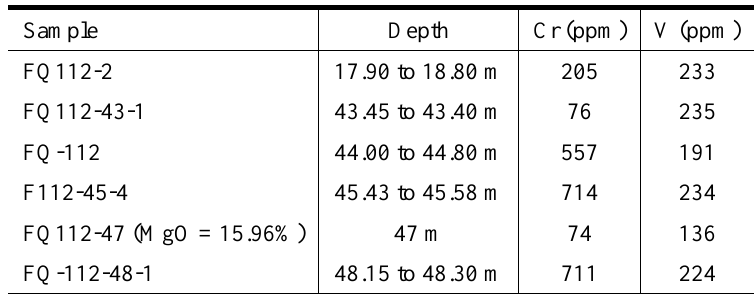
XRF analyses (Cr and V) of host rocks of Quartzito quartz